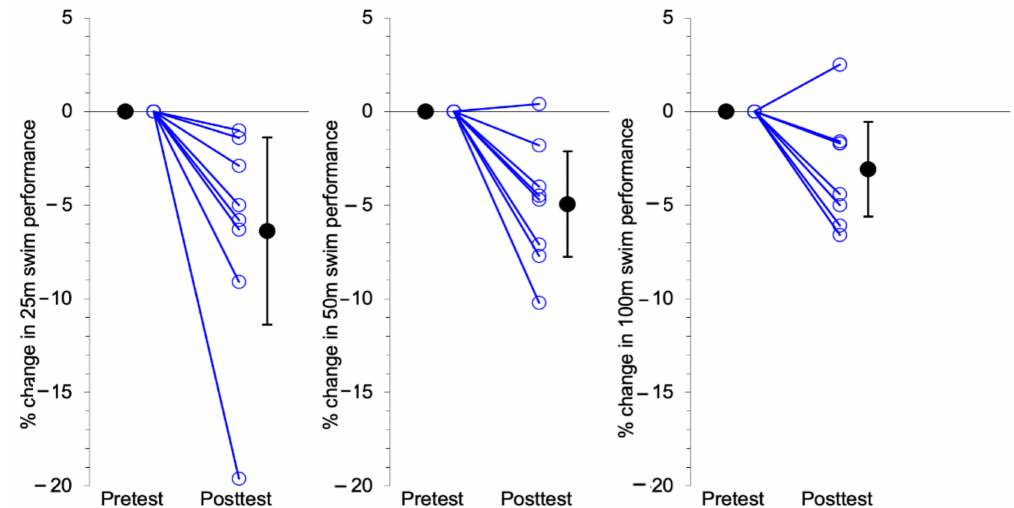
Figure 1. Individual (open blue circles) and mean (solid black circles with 95% Confidence Intervals) improvements in swimming performance times from pre- to post-training for 25 m, 50 m and 100 m freestyle